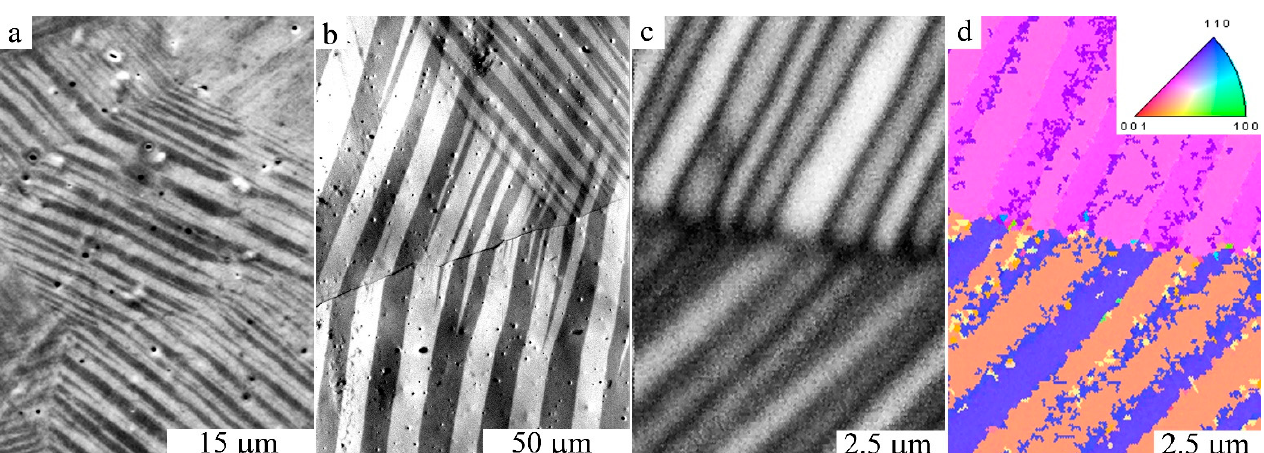
Table 1. Type, crystal structure parameters ( a , b , c ), and specific atomic volume ( V ) of phases in the alloy Ni 50 Mn 28.5 Ga 21.5.